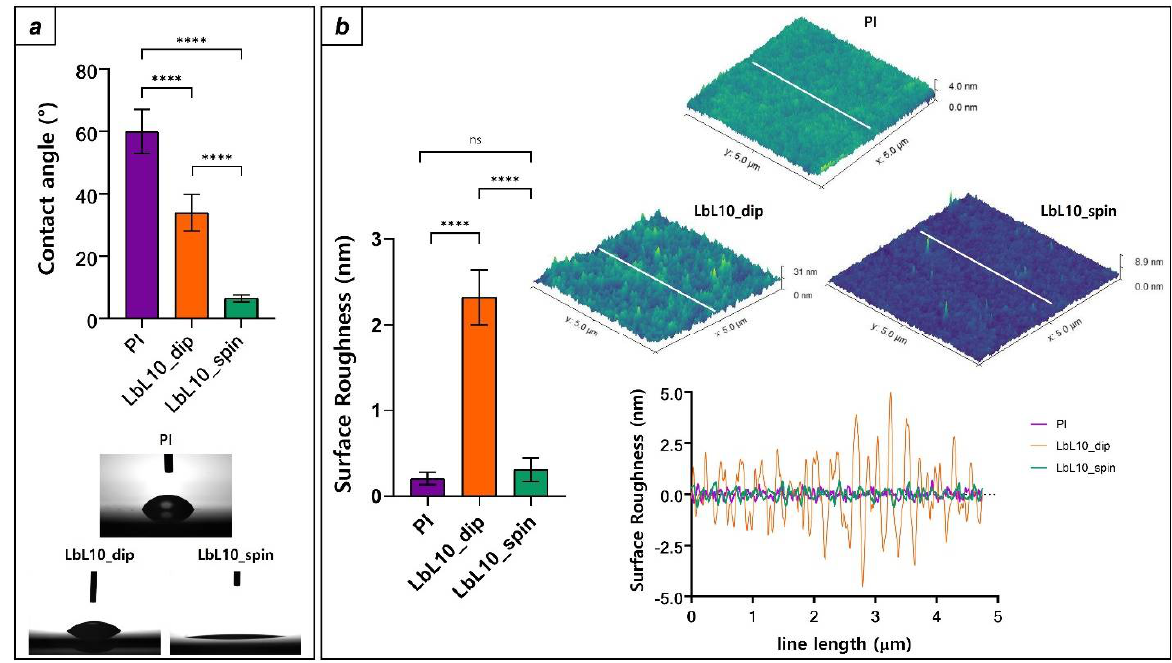
Figure 7. Physiochemical properties of the two LbL assembly methods compared with the PI surface. ( a ) CA values of the two LbL techniques compared with PI. At the bottom of the box are shown representative images of water-drop spreading for each sample typology, evidencing differences in surface wettability. ( b ) Summary of AFM analysis reporting variations in average surface roughness for each sample in the histogram and 3D reconstruction of 5 μm × 5 μm surface topography of PI, LbL10_dip, and LbL10_spin. At the bottom of the box plot of surface roughness, the profile relative to the white line drawn in each AFM scan is shown.